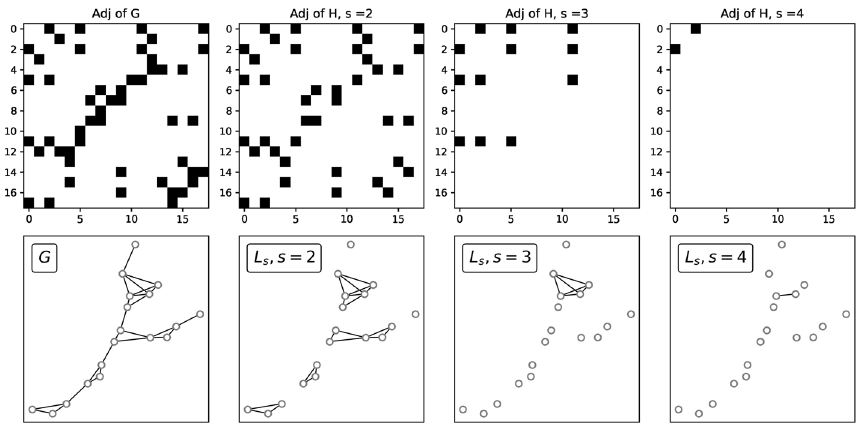
Fig. 3 Adjacency matrices and line graphs. Top: generalized node s -adjacency matrices for different values of s from a given toy graph G . Bottom, from left to right: reference network G , and s -line graphs for s = 2,3,